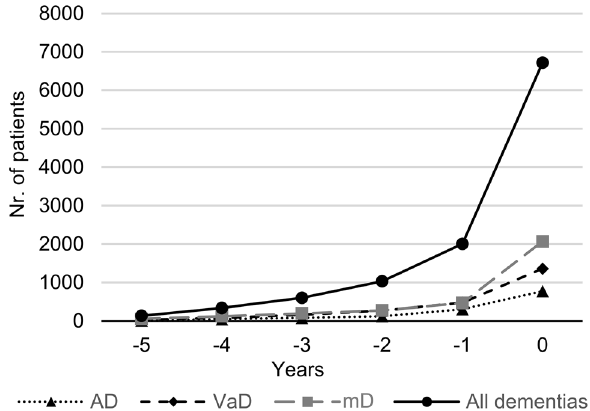
Figure 2. The relationship between types of dementia and MCI. MCI assigned to patients with AD, VaD, mD and all dementia diagnoses. In case of zero, the patient received MCI and another diagnosis in the same year. The date of the first diagnosis given to a patient was used for the analysis. Nr. Number.